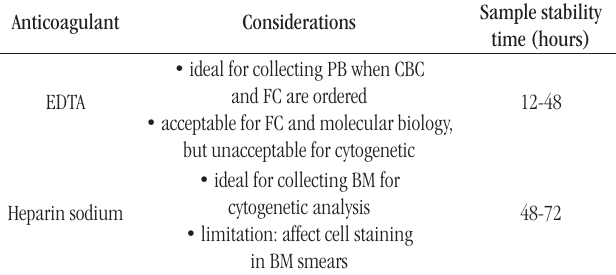
taBLE 1 − Characteristics of the anticoagulants used in PB and BM collection for immunophenotyping by FC (2) Anticoagulant Considerations Sample stability